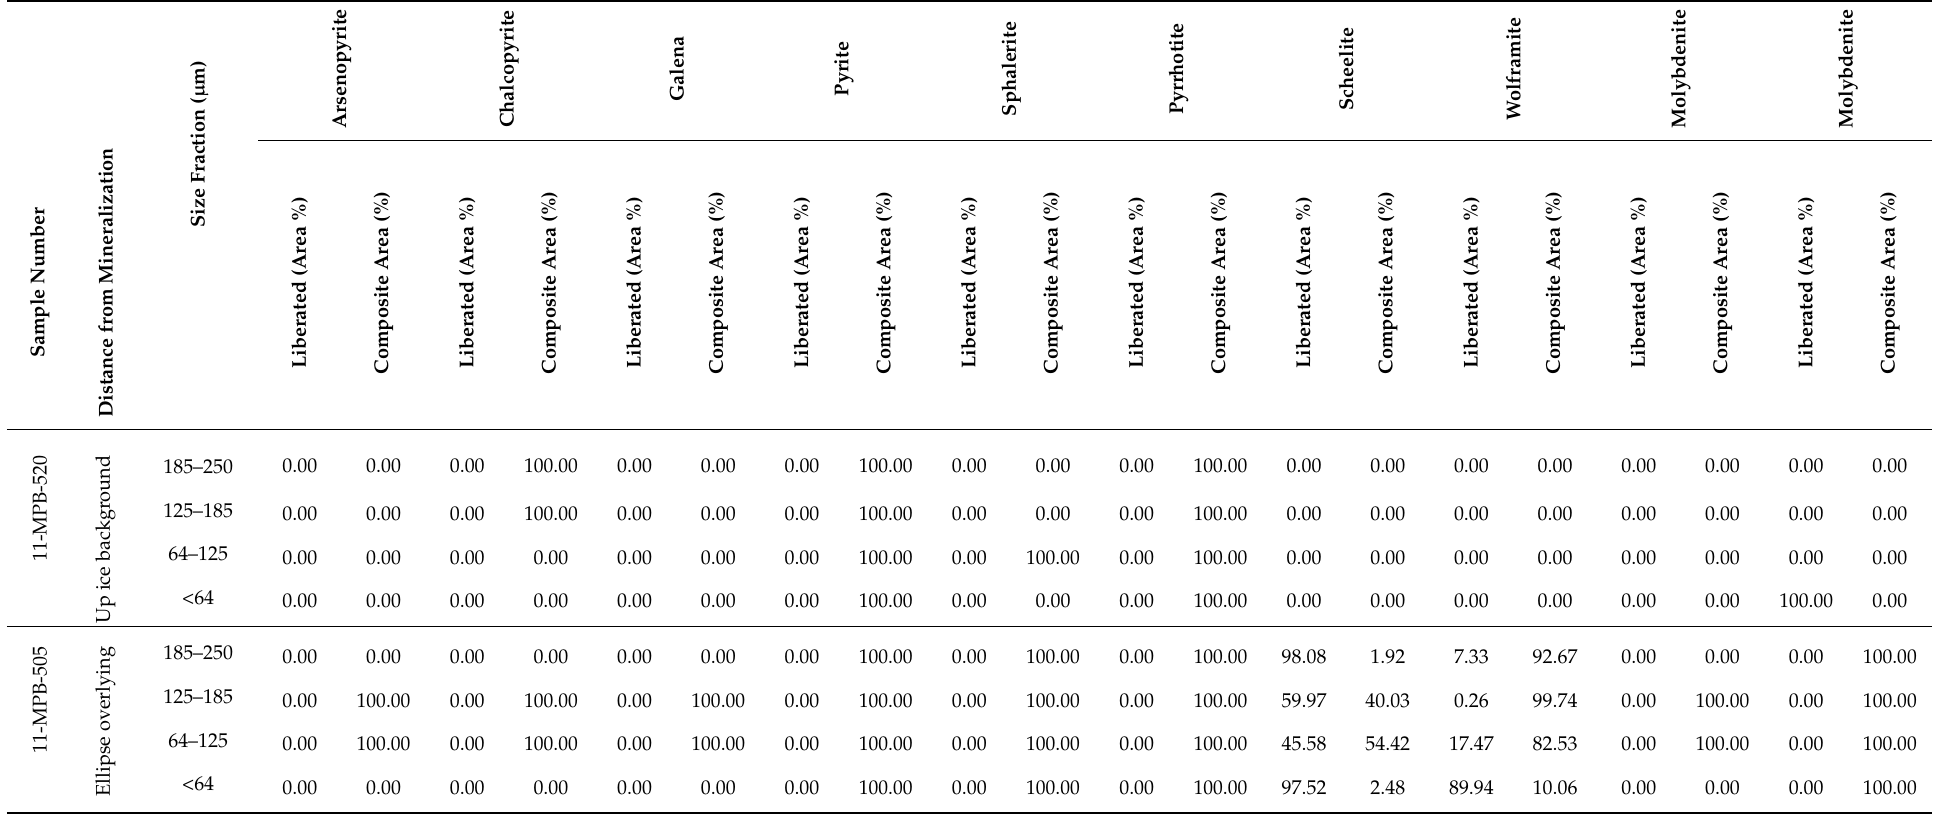
Table 6. The proportion (area per cent) of ore and sulfide minerals in till samples from the Sisson deposit, New Brunswick, present as either liberated grains or as a component of a composite